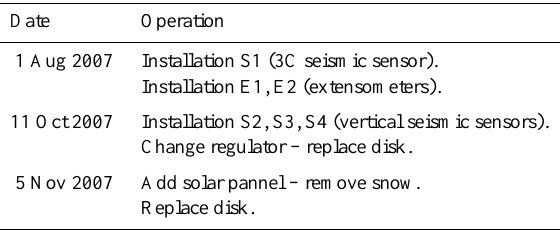
Table 1. Synthesis of the installation and maintenance operations.